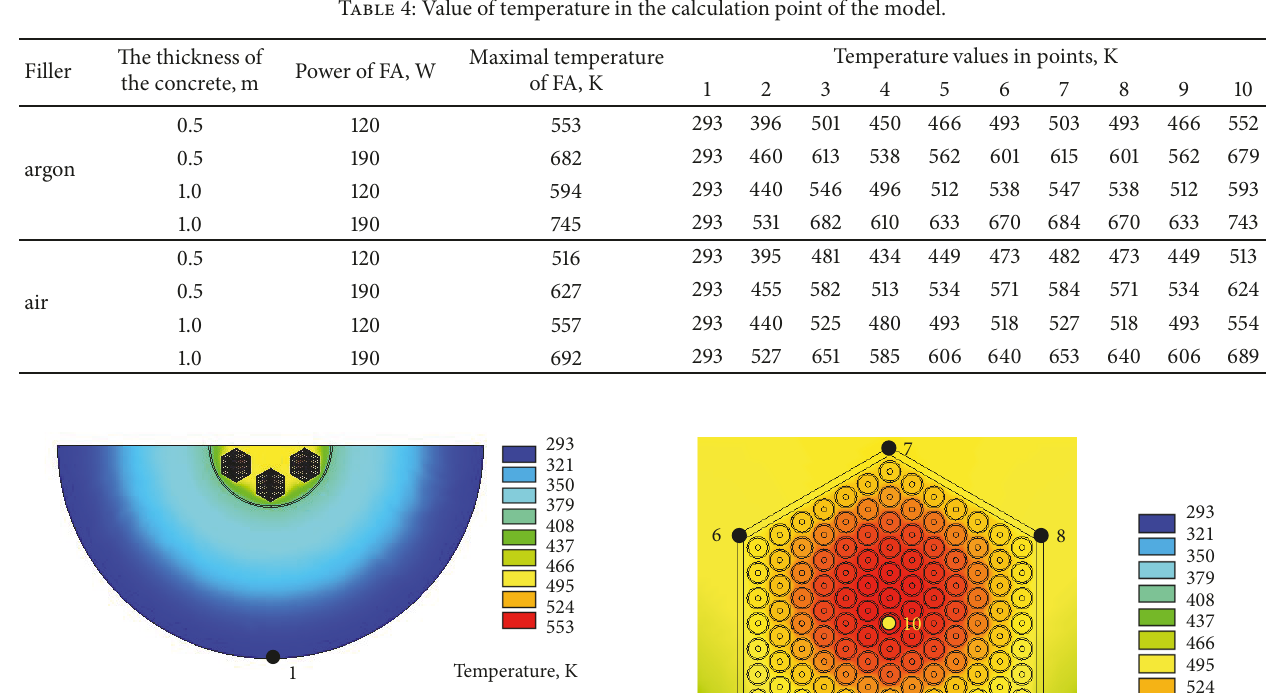
Figure 3: Temperature field of the cask and the concrete around.